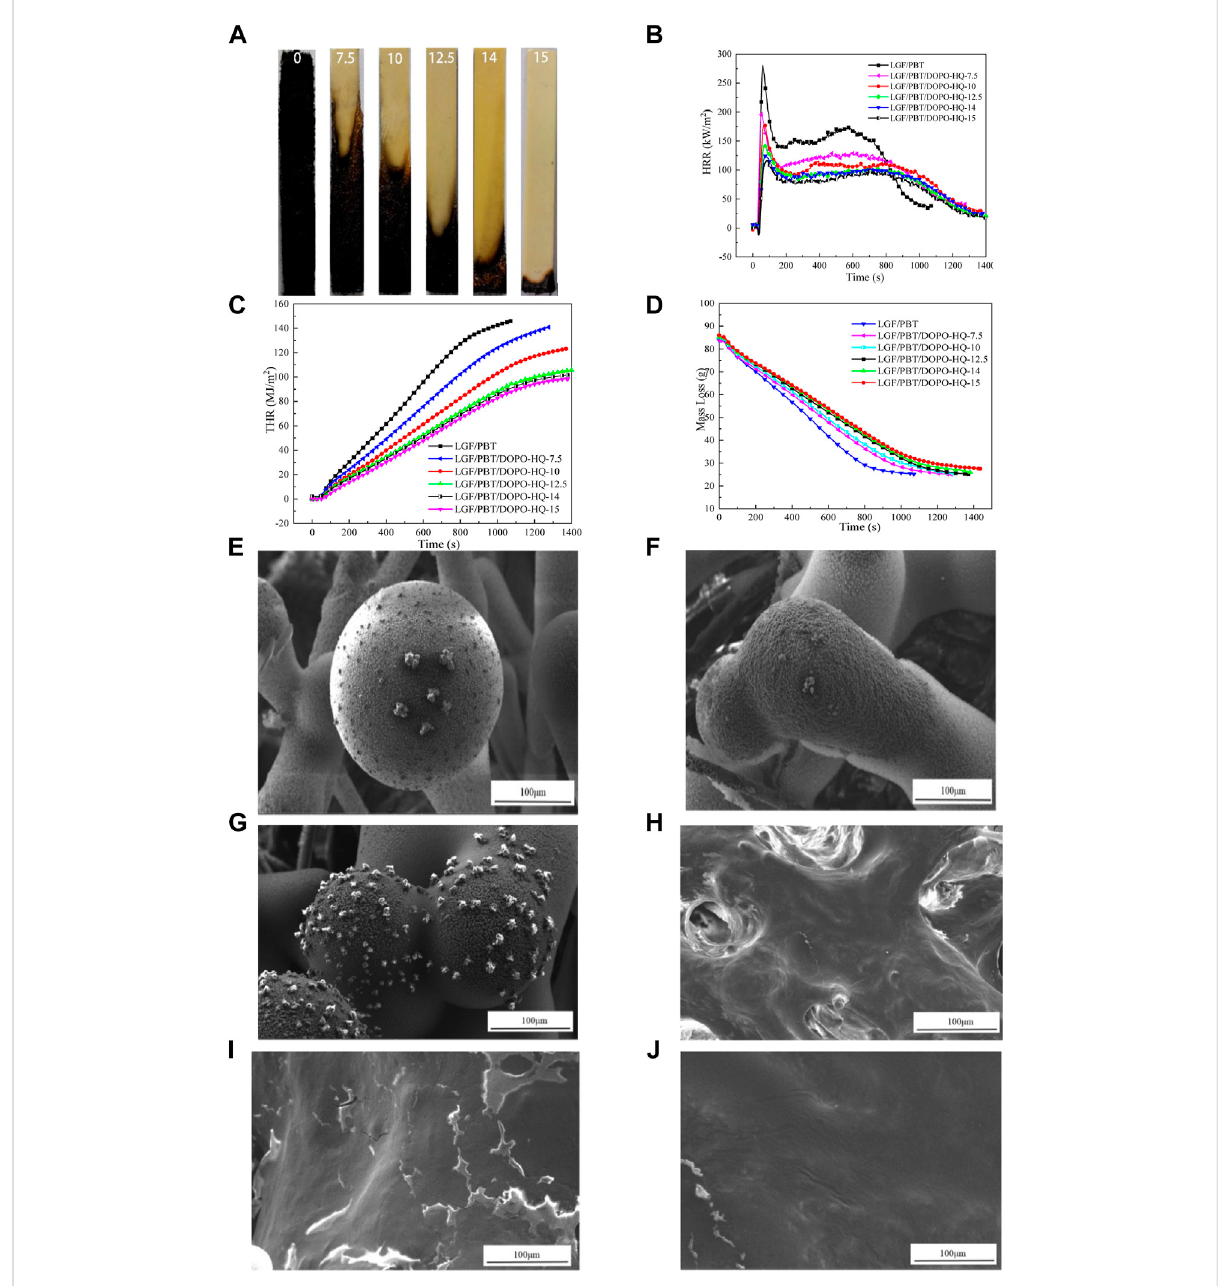
FIGURE 1 (A) The pictures of LGF/PBT/DOPO-HQ-conjugated fl ame-retardant composites after UL-94 testing: (DOPO-HQ: 0;7.5;10;12.5;14; 15%); (B – D) the curves of LGF/PBT/DOPO-HQ-conjugated fl ame-retardant composites at an external heat fl ux of 50 kW/m2 as a function of burning time: (B) HRR; (C) THR; (D) Mass Loss; (E – J) the microstructure (1000 magni fi cation) of the burning surface of LGF/PBT/DOPO-HQ-conjugated fl ame-retardant composites. (E) LGF/PBT; (F) LGF/PBT/DOPO-HQ-7.5; (G) LGF/PBT/DOPO-HQ-10; (H) LGF/PBT/DOPO-HQ-12.5; (I) LGF/ PBT/DOPO-HQ-14; (J)